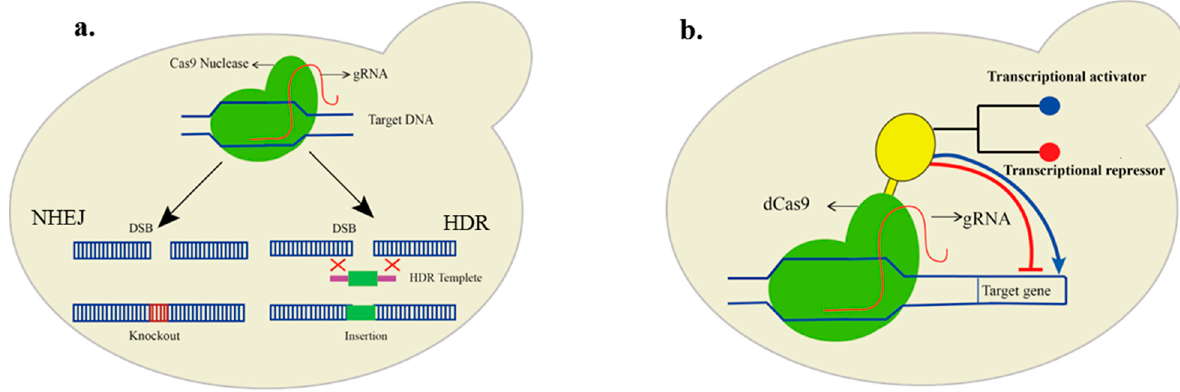
Figure 1. Genetic engineering in yeast using CRISPR/Cas9. ( a ). Cas9, together with guide RNA, induces a double-stranded break (DSB). The DSB is repaired by the cell either through the error-prone non-homology end joining (NHEJ) or in the presence of repair fragments with homology arms; foreign DNA is inserted into the DNA through homology-directed repair (HDR) mechanism. ( b ). The nuclease deficient (dCas9) is fused with a transcriptional regulator (yellow color). In the case of a transcriptional activator (blue), the targeted gene is activated, while in the case of a transcriptional repressor (red), its transcription is deactivated.